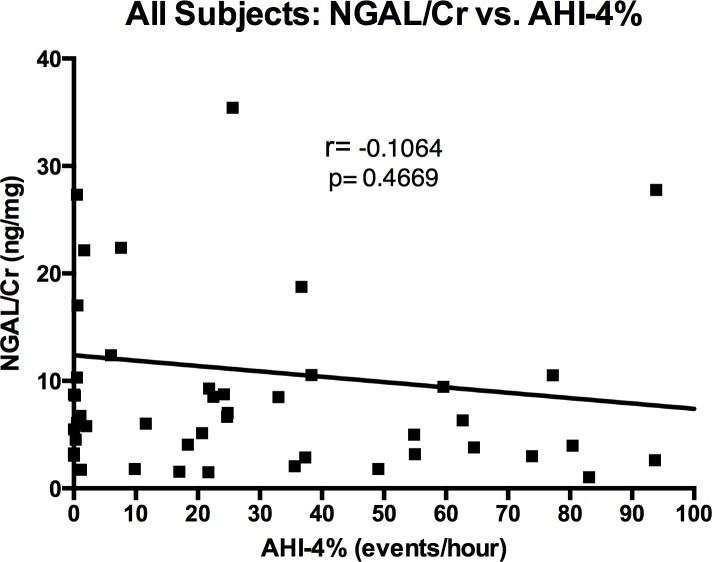
Individual NGAL-to-Creatinine Ratios (NGAL/Cr; ng/mg) versus Apnea-Hypopnea Indices (AHI-4%; events/hour) among All Subjects (Untreated Sleep Apnea and Control).